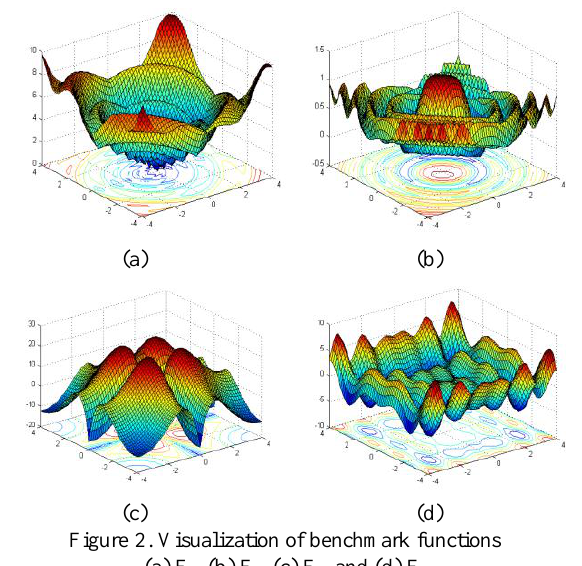
Figure 2. Visualization of benchmark